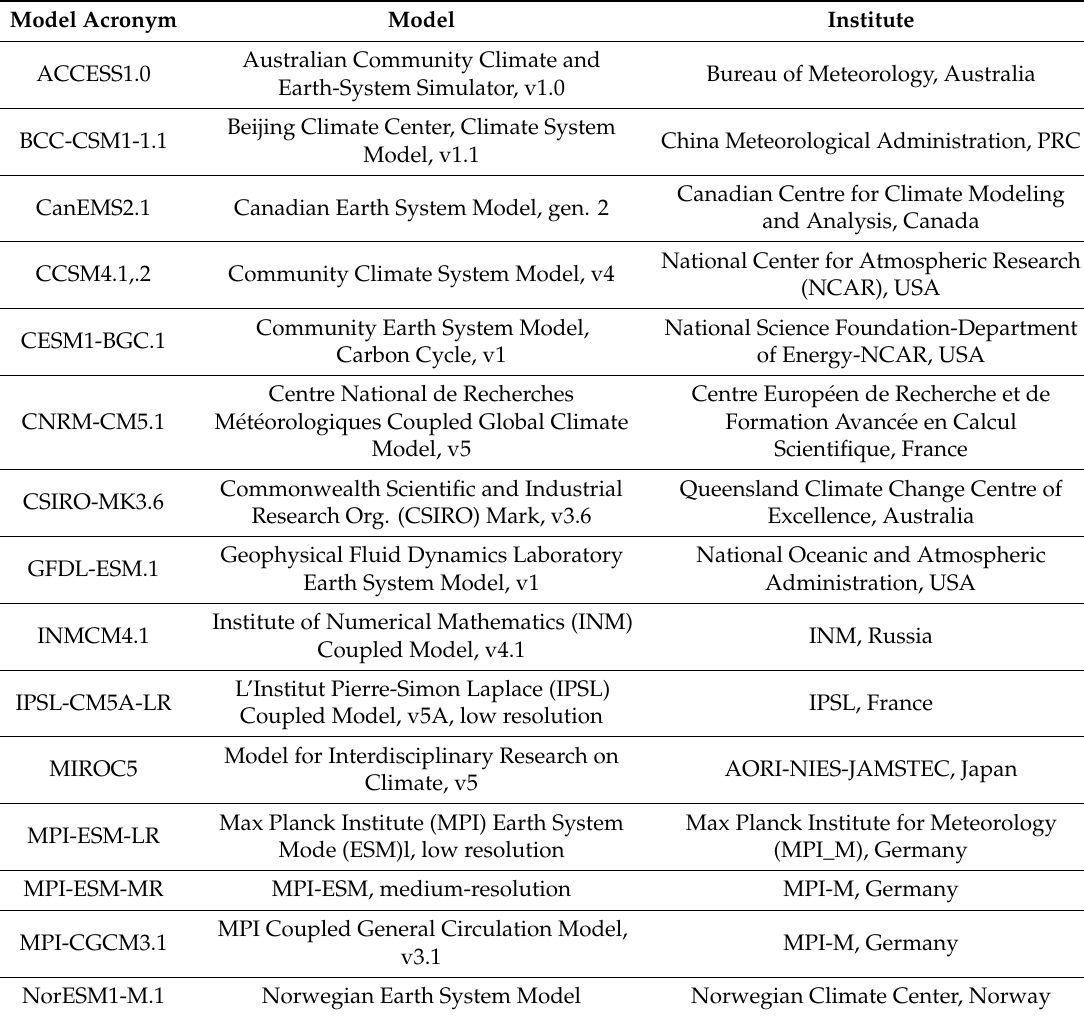
Table 1. List of models contributing to CMIP5 GCM and associated RDC model data